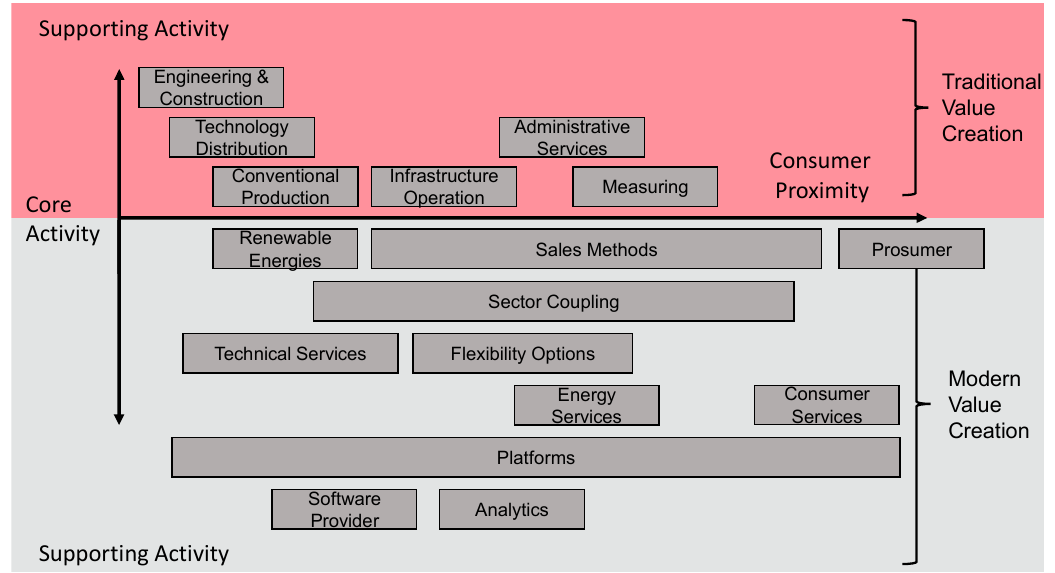
Figure 7. Dimensions for classifying the business models.